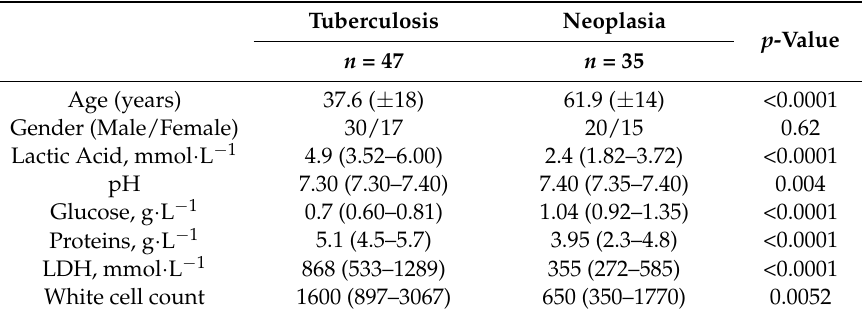
Table 1. Baseline characteristics. Data are media (SD) or median (IQR).